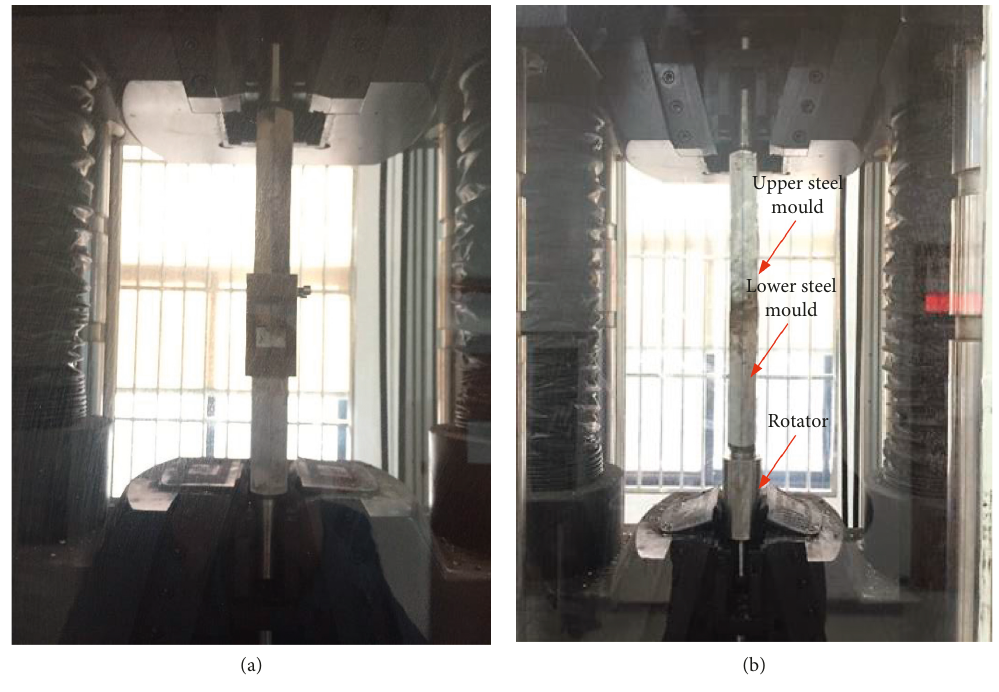
Figure 4: Setup of DEPT devices with and without a rotator.